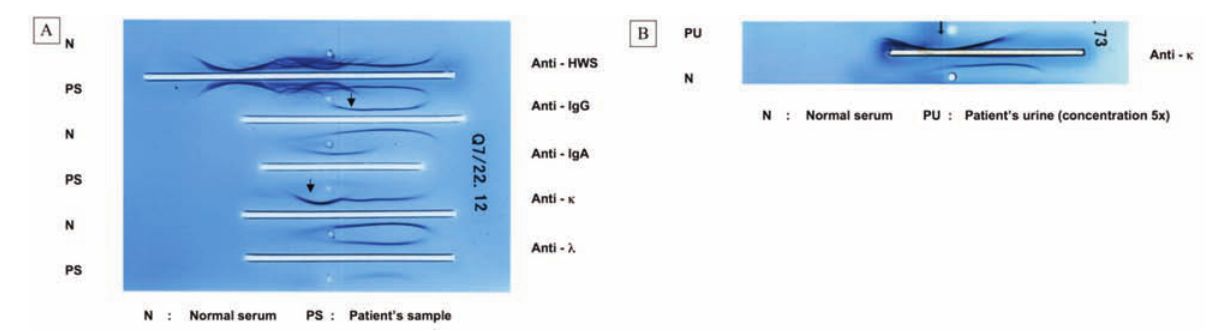
Figure 2. Immunofluorescence staining. A) the bone marrow paraffin section was immunostained with FITC conjugated rab- bit anti-human IgG antibodies (green); B) the same specimen was stained with rabbit anti-human IgE antibody and Alexa Fluor594-labeled goat anti-rabbit IgG antibody (red); C) dual staining using anti- IgG and anti-IgE as in A and B; a part of the cells shows yellow, indicating that they are positive for both IgG and IgE.